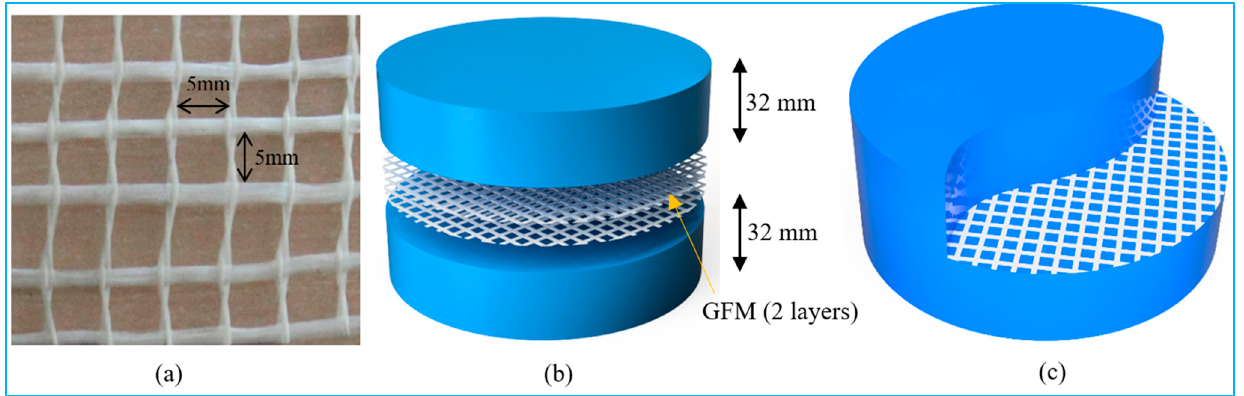
Figure 3. Size of GFM and location of insertion ( a ) square grid of GFM, ( b ) GFM location from the top and bottom surface, ( c ) appearance of GFM after insertion.